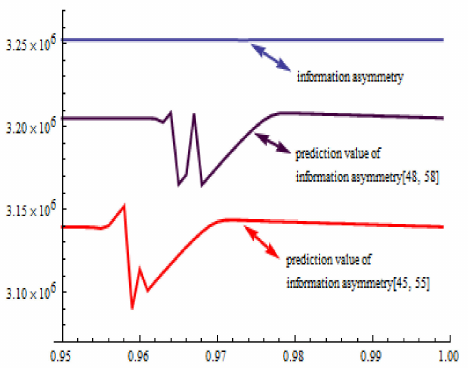
Figure 4. Trend chart of the expected revenue of the supplier.